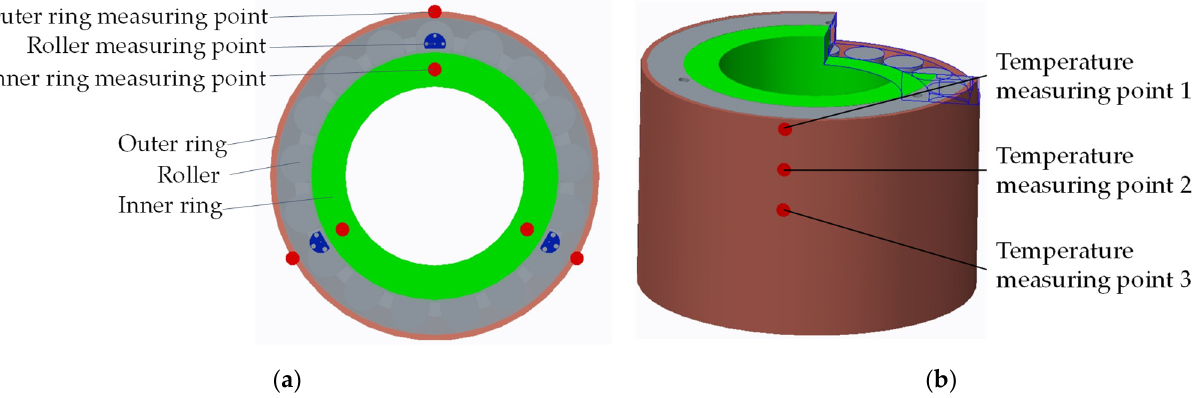
Figure 9. Location of temperature measuring point of railway bearing: ( a ) circumferential tempera- ture measuring point; ( b ) axial temperature measuring point of outer ring.